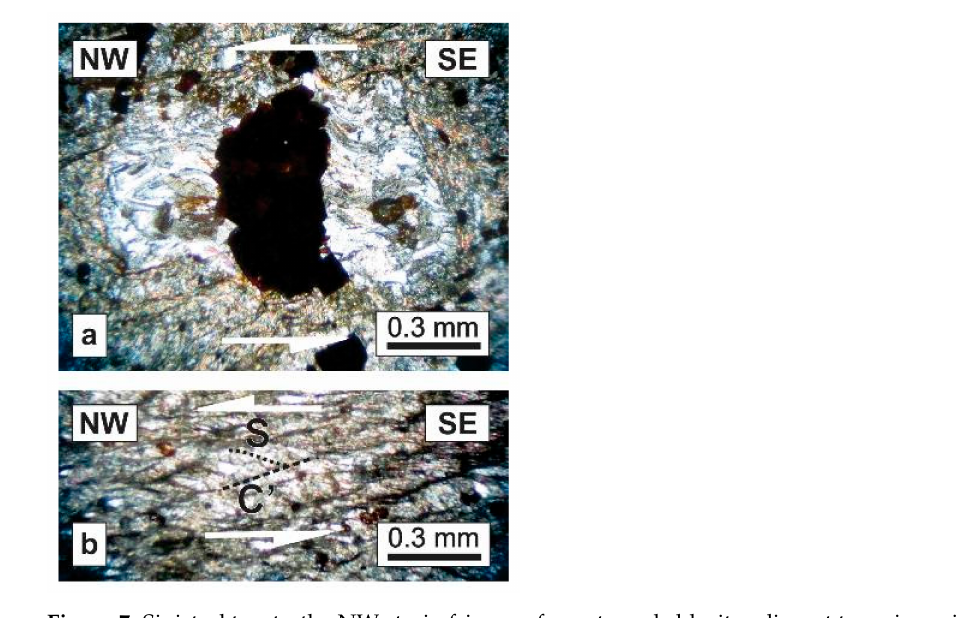
Figure 7. Sinistral top-to-the NW strain fringes of quartz and chlorite adjacent to an inequidimen- sional pyrite grain ( a ) and sinistral top-to-the NW C’-type shear bands cleavage ( b ) in the XZ-planes of the calcite tectonites in the Chah-e-Sefid shear zone [34]. The antitaxial fringe structure is displace- ment controlled ( a